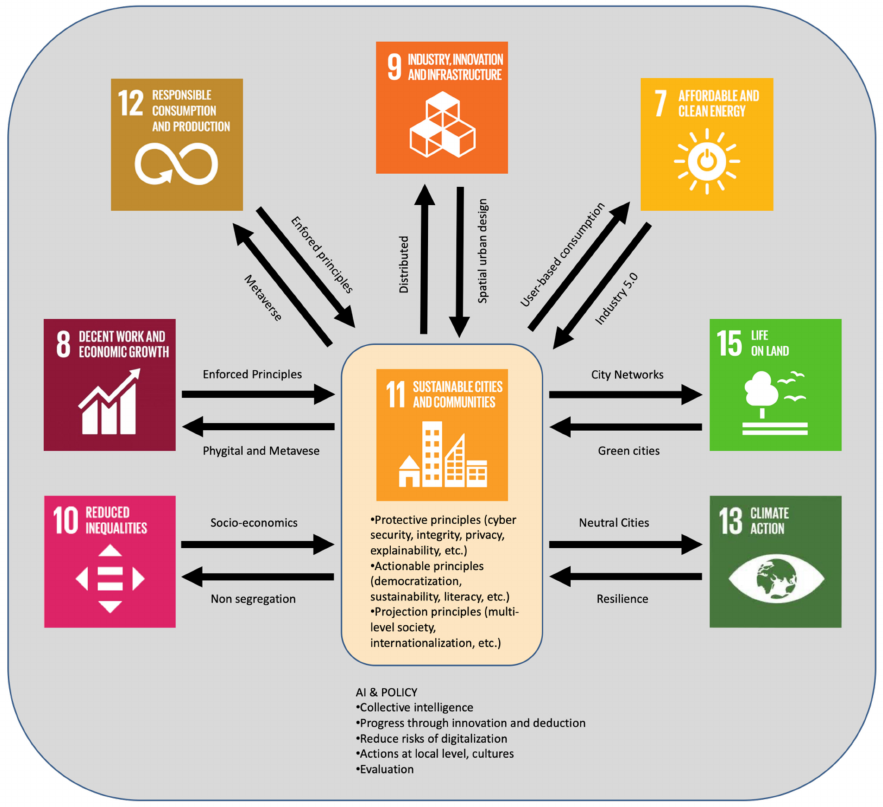
Figure 1. Ethical framework proposed in this work in the context of sustainable